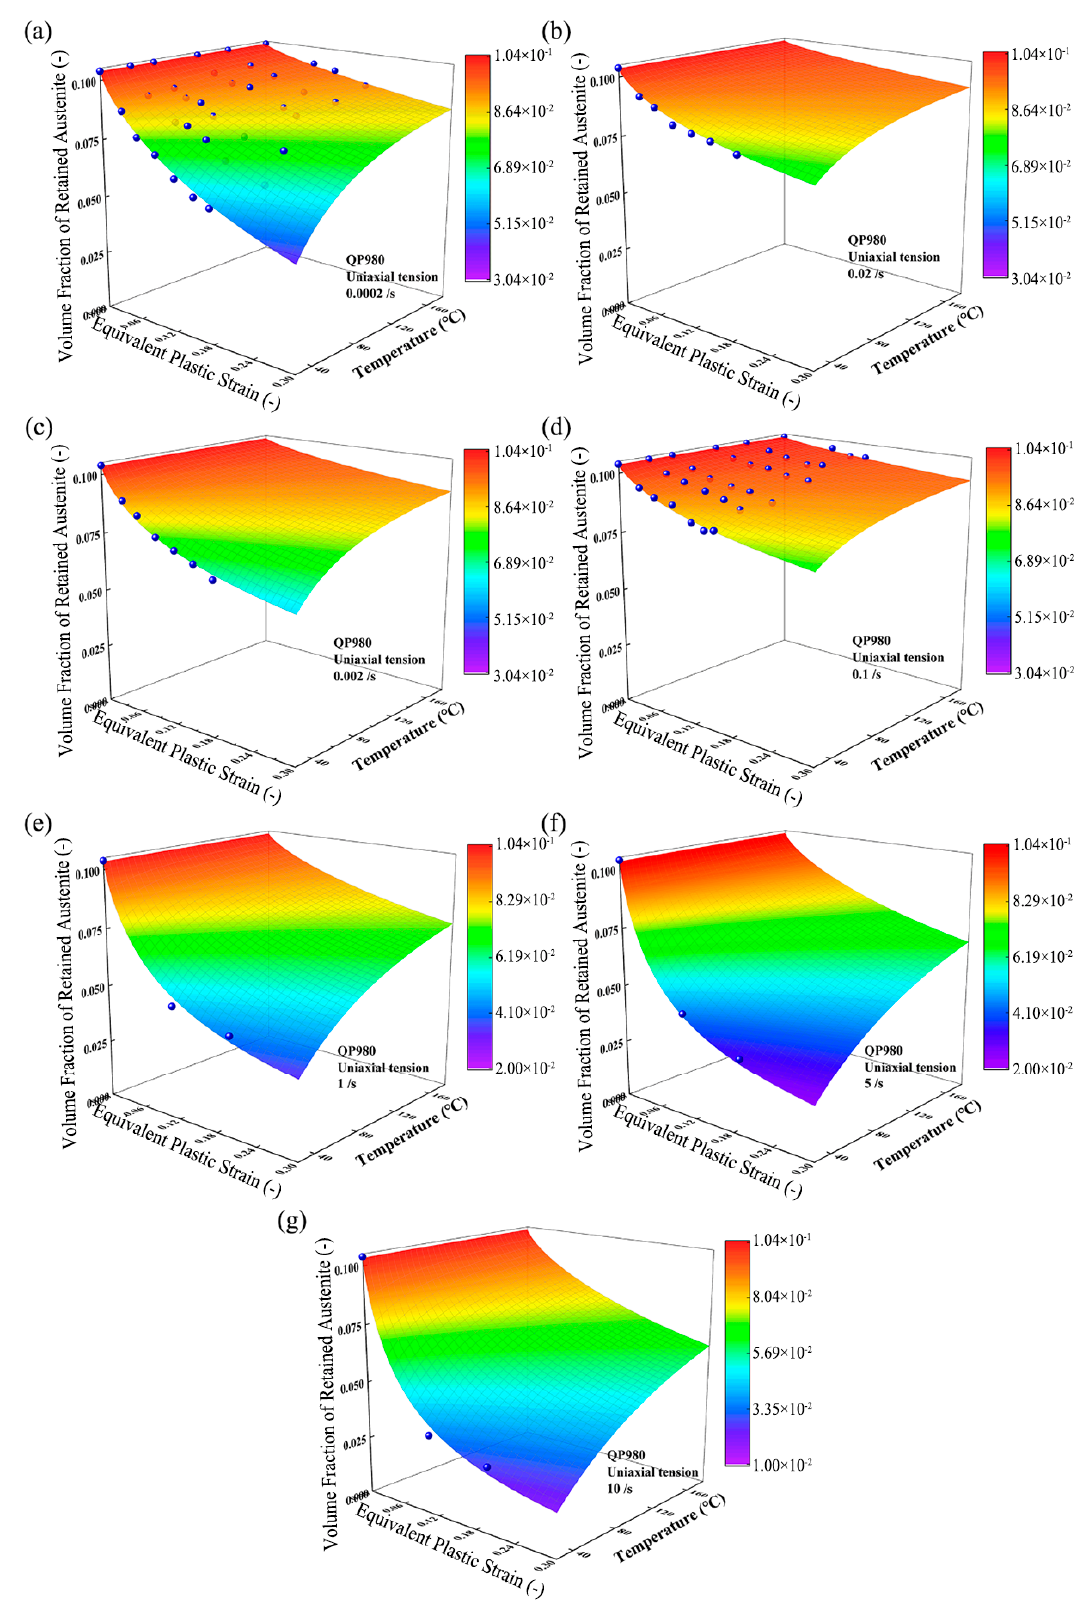
Figure A2. Retained austenite evolution with EPS and temperature at various strain rates: ( a ) 0.0002/s; ( b ) 0.002/s; ( c ) 0.02/s; ( d ) 0.1/s; ( e ) 1/s; ( f ) 5/s; ( g ) 10/s (The blue balls are the experimental data).